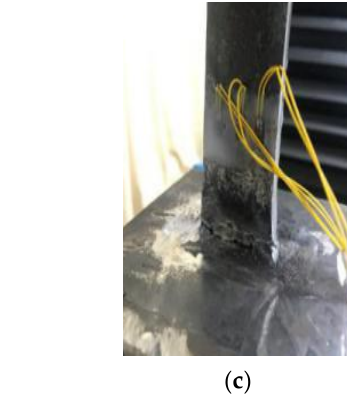
Figure 7. Failure mode of plate joints under monotonic loading: ( a ) S-4; ( b ) S-5; ( c ) S-6.